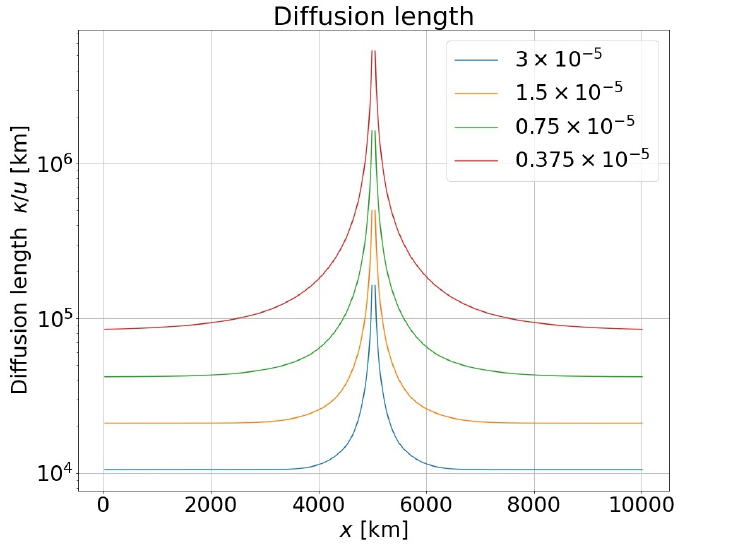
Figure 5. The calculated diffusion lengths of energetic particles for simulations of a coronal loop with the size L = 10,000 km and the spatial cell size ∆ x = 20 km. The curves are cut off to avoid presenting the diverging values of the diffusion length in the middle. Different normalization values α are denoted in the